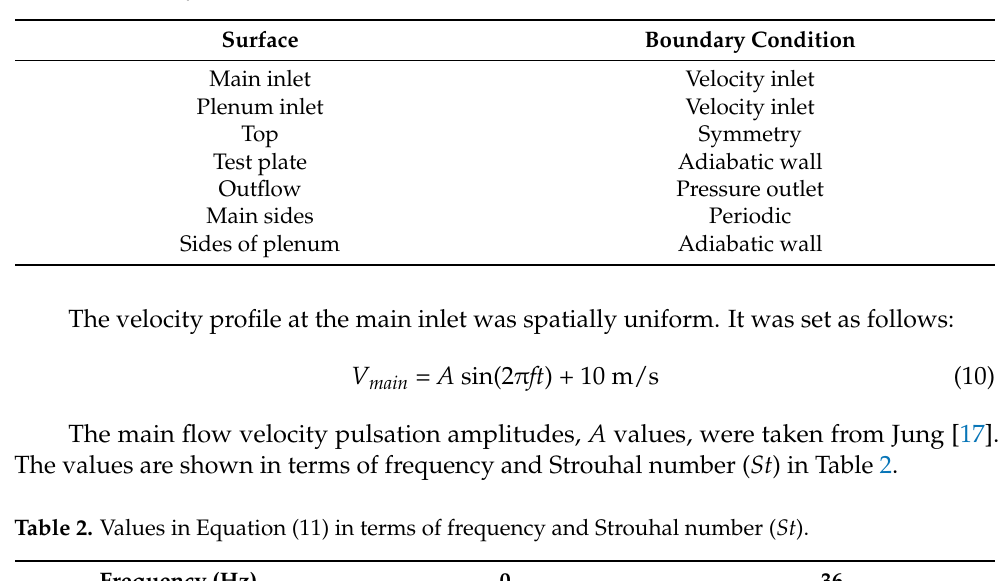
Table 1. Boundary conditions.